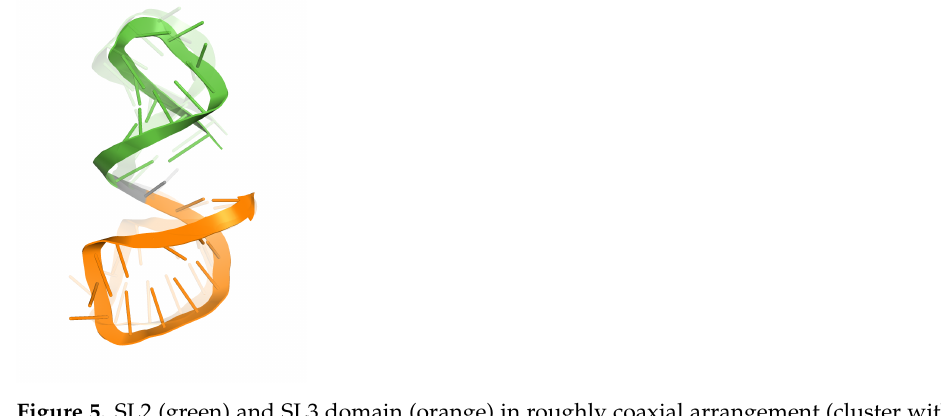
Figure 5. SL2 (green) and SL3 domain (orange) in roughly coaxial arrangement (cluster with two